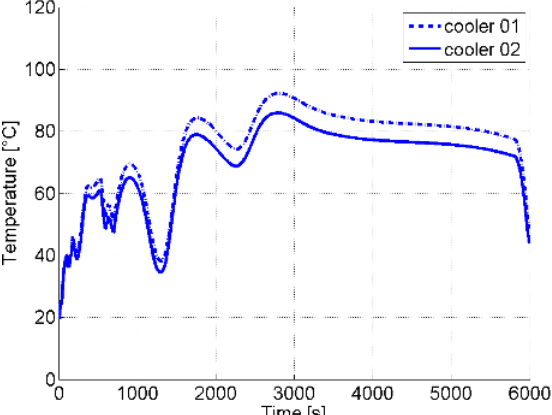
Fig. 7. Temperature of the cooling fluid behind the engine in a course of time.